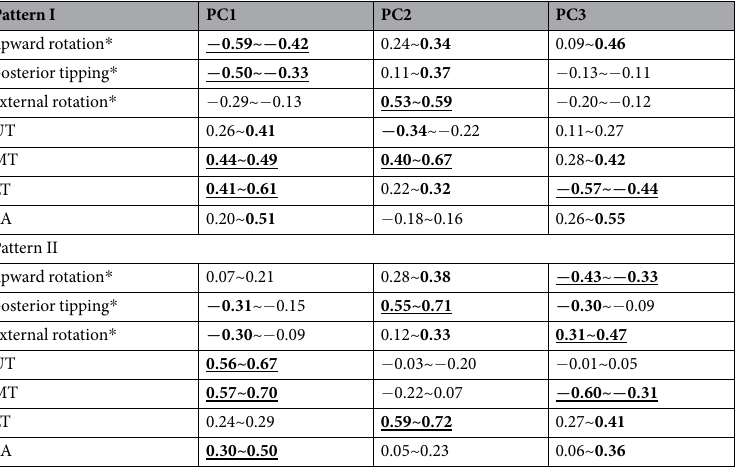
Table 2. Principal component analysis, correlation between principal components (PCs) and 3-dimensional scapular kinematics/4-muscle EMG. Pattern I: Inferior medial angle of the scapula is displaced posteriorly from the posterior thorax, prominent during dynamic observation and palpation; Pattern II: Entire medial border of the scapula is displaced posteriorly from the posterior thorax, prominent during dynamic observation and palpation. * : 3-dimensional scapular kinematics; UT: upper trapezius; MT: middle trapezius; LT: lower trapezius; SA: serratus anterior. Bold with or without underline indicates moderate to high